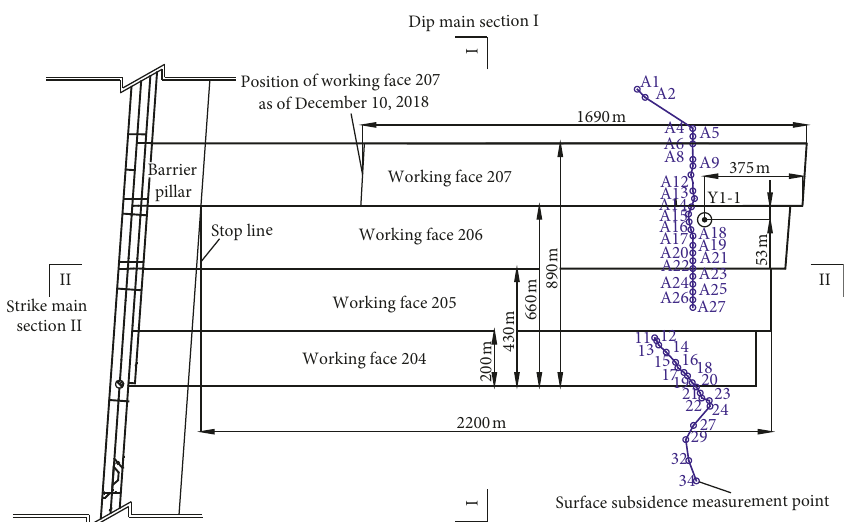
Figure 1: Map of the layout of the working area in the second panel and the positions of surface subsidence measurement